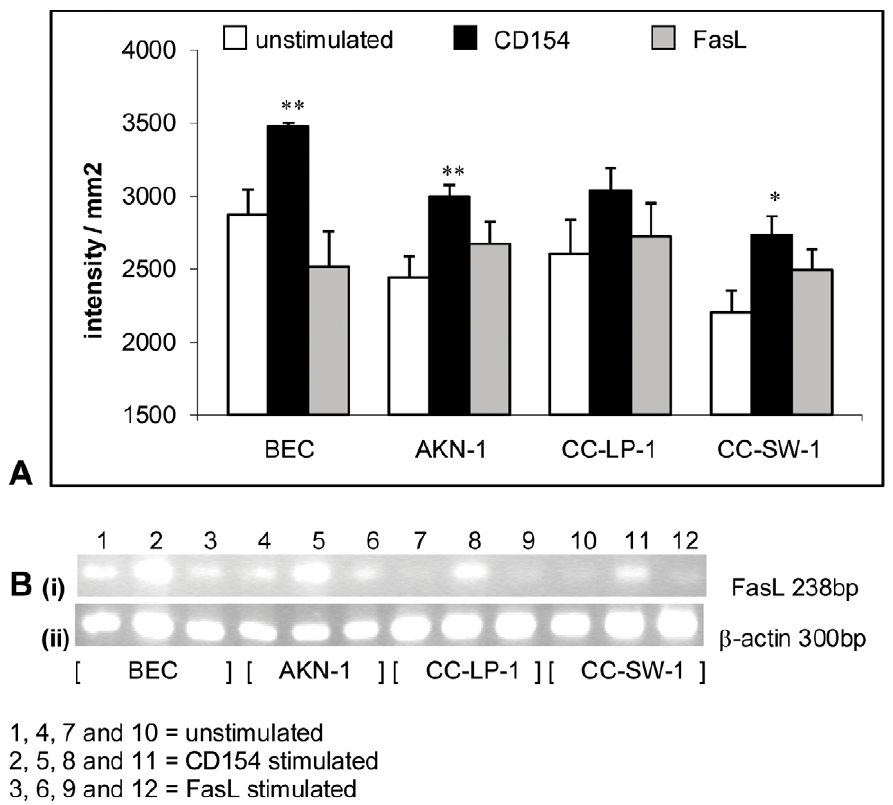
Figure 2. Fas ligand induction to promote apoptosis assessed by RT-PCR at 4 hours. Cells were grown in culture media alone, stimulated with srh CD154 at 1 m g/ml or srh FasL at 50 ng/ml for 4 hours. (a) densitometry scanning data for FasL PCR gels at 4 hours. n=4 + / 2 standard error of the mean. (b i) a representative FasL PCR gel and (b ii) the corresponding b -actin gel. *p , 0.05, **p , 0.01 as compared to untreated controls.